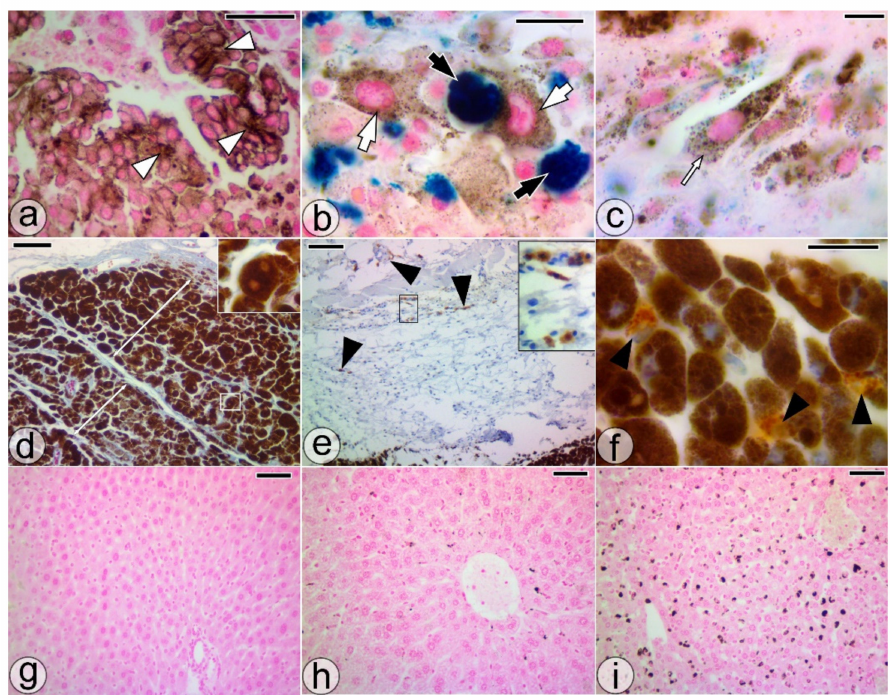
Figure 2. Histological sections through orally treated melanoma (T4w). ( a ) PMC clusters (white arrowheads) with perimembranous accumulation of pigment granules. ( b , c ) PMCs (white arrows), NP-PMCs (thin white arrows), and large SaIONs-laden cells (black arrows) in tumor areas with nanoparticle-induced necrosis. ( d ) HPMCs, including some binucleate cells (square), forming over- lapping layers at the periphery of the tumor (double-headed arrows). ( e , f ) MAC387(+) cells (black arrowheads) in juxtatumoral tissue or spread among HPMCs. ( g – i ) Microscopic appearance of the liver with pigment deposits in M4w, T2w, T4w groups, respectively. Perl Prussian blue ( a – c ), Azan Trichrome ( d ), and HE staining ( d , g – i ). Bar = 100 µ m ( e – i ), 50 µ m ( a , d ), 10 µ m ( b , c , f